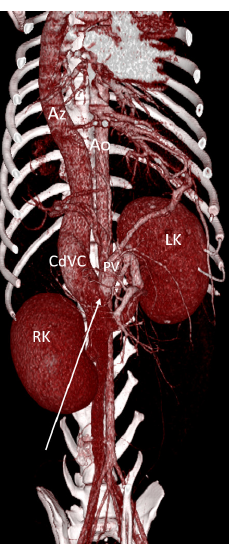
Figure 3. Volume rendered image (ventral view) of a dog with extrahepatic CAPV, portal insertion in the renal segment of the CdVC (arrow). This is an example of end-to-side portosystemic shunt. There is simultaneous azygous continuation of the CdVC due to congenital absence of renal and prehepatic CdVC segments. Moreover, the dog showed situs inversus abdominalis (note the left-sided mesenteric and portal veins, the caudal right kidney and cranial left one). LK, left kidney; RK, right kidney.